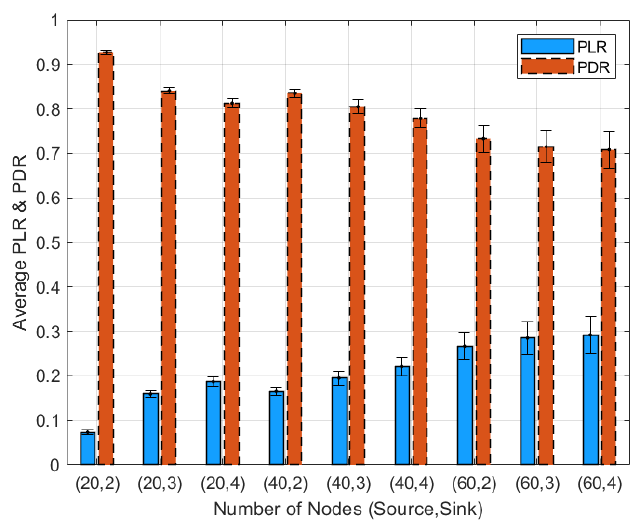
Figure 12. Selection consistency.